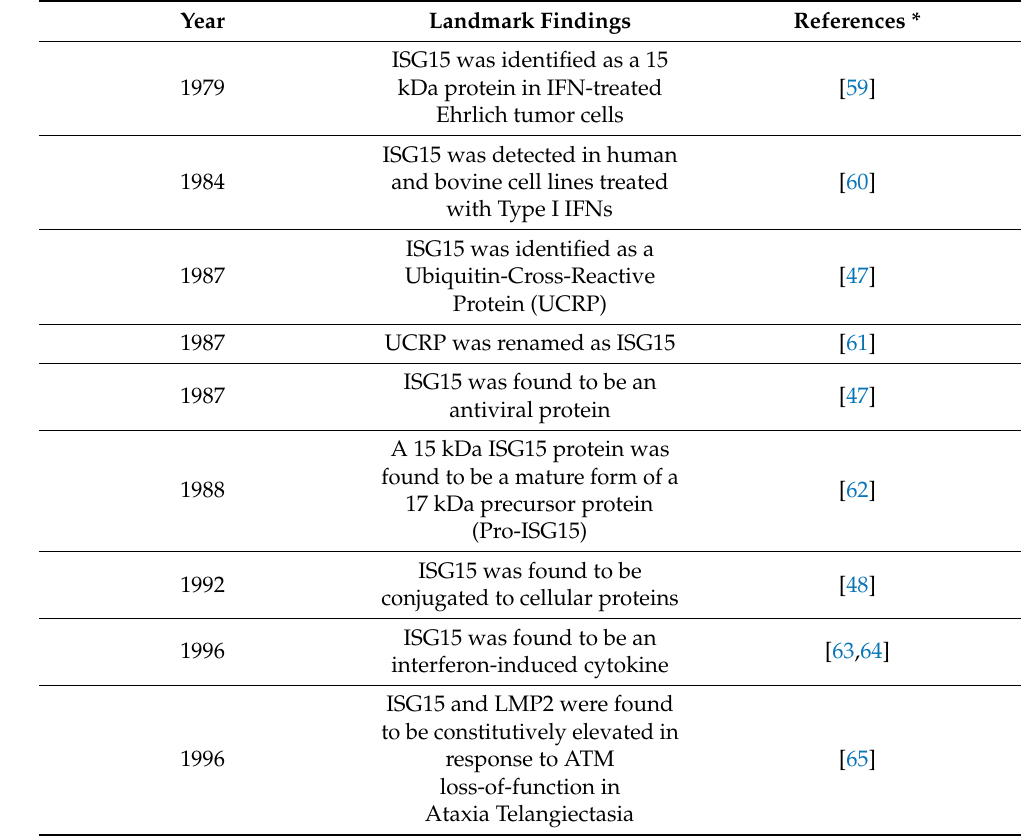
Table 2. ISG15: journey from bench to